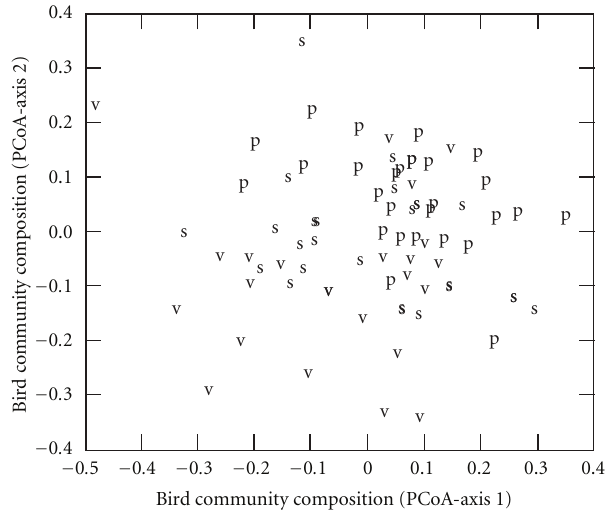
Figure 2: Results from Principal Coordinate Analysis (PCoA) used to generate a simple ordination of 72 areas at the Reserva Florestal Adolpho Ducke (RFAD), Manaus, Brazil, based on the similarity matrix of distances generated by the Sorensen index for the qualita- tive matrix (presence and absence data) for the entire bird commu- nity. Letters represent the 72 areas in which the bird species were sampled using 240 m mist-net lines placed throughout the RFAD (p = plateau; s = slopes; v = valleys). The closer the points are to one another in the graph, the more similar are their bird species community composition. Note that the species composition, with a group of p in the upper part, a group of s in the middle, and a group of v in the lower part, changes significantly along the topographical gradient from plateau to valleys.